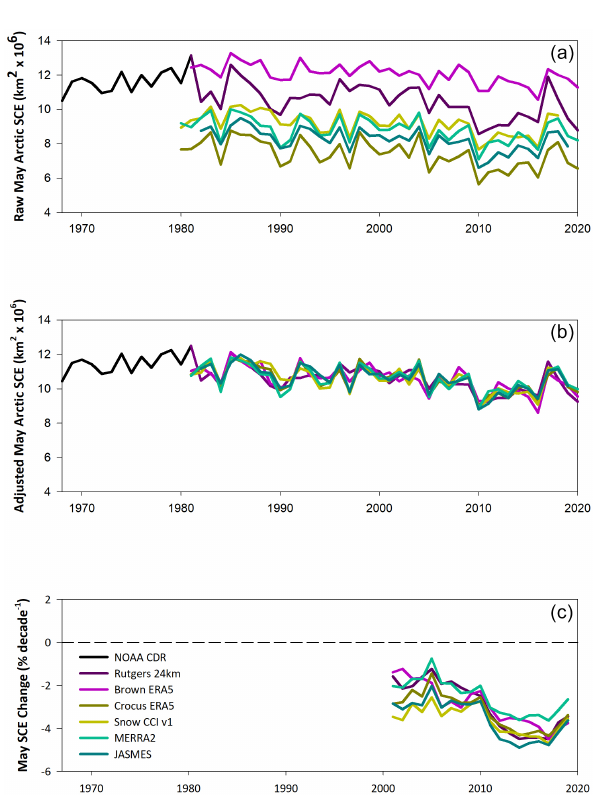
Figure 1. Raw time series of May Arctic snow extent (a) , adjusted time series (b) , and rate of change since 1981 of adjusted time se- ries (c)